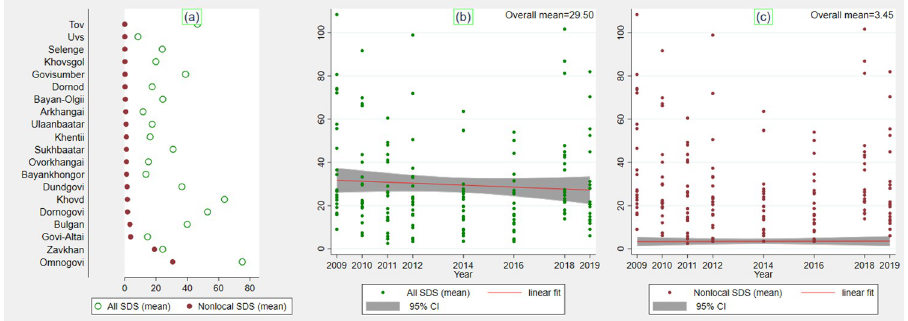
Fig 2. The overall running average of weighted SDS by province and over the years. Source: Authors’ composition based on the MIDAS/CEDA dataset.